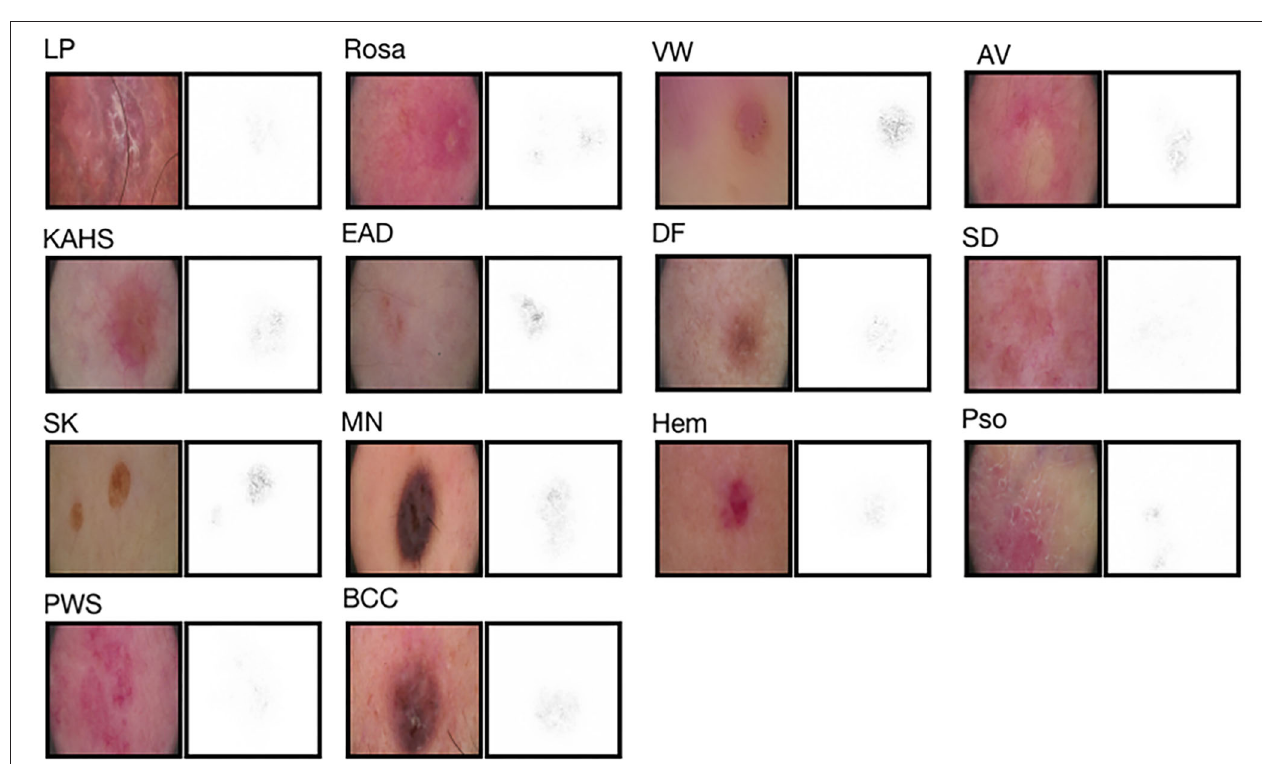
FIGURE 3 | Saliency maps for 14 example images from validation set. Saliency maps for example images from each of the 14 disease classes of the validation set reveal the pixels that most influence a CNN’s prediction. Saliency maps show the pixel gradients with respect to the CNN’s loss function.